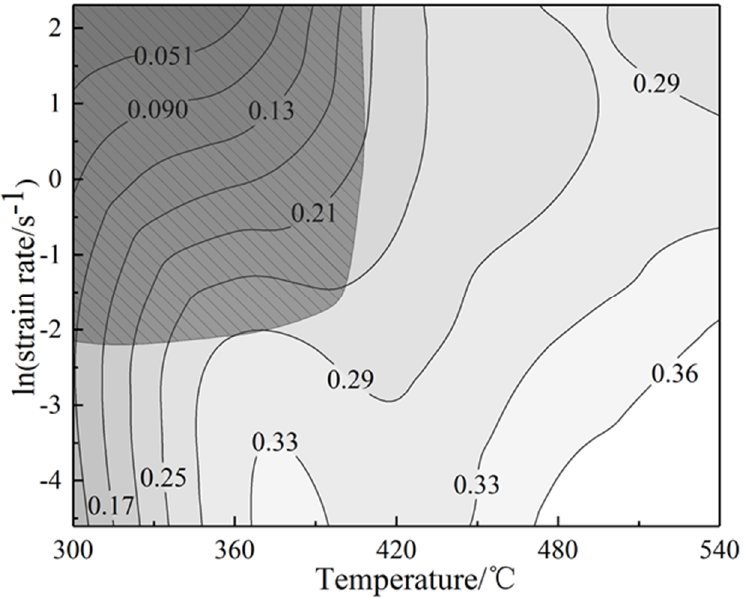
Figure 6. Two-dimensional hot working map of the composite modified 6063 aluminum alloy at a true strain of 0.7.